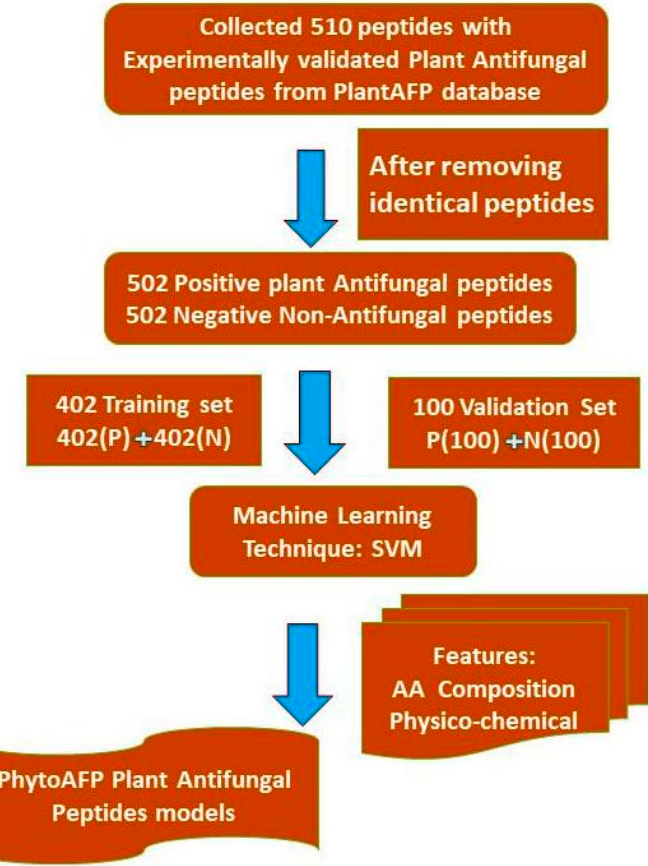
Figure 2. Architecture of PhytoAFP.